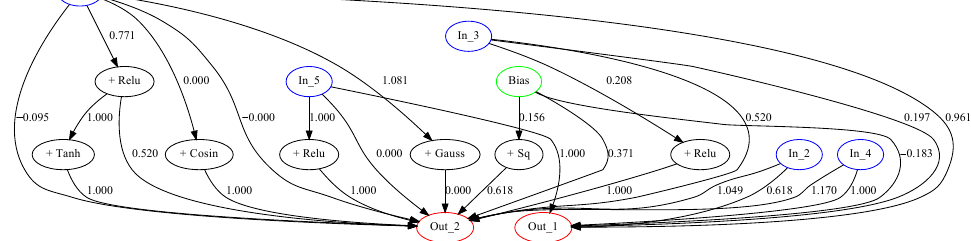
Figure 2. Graph of solution from run 29.